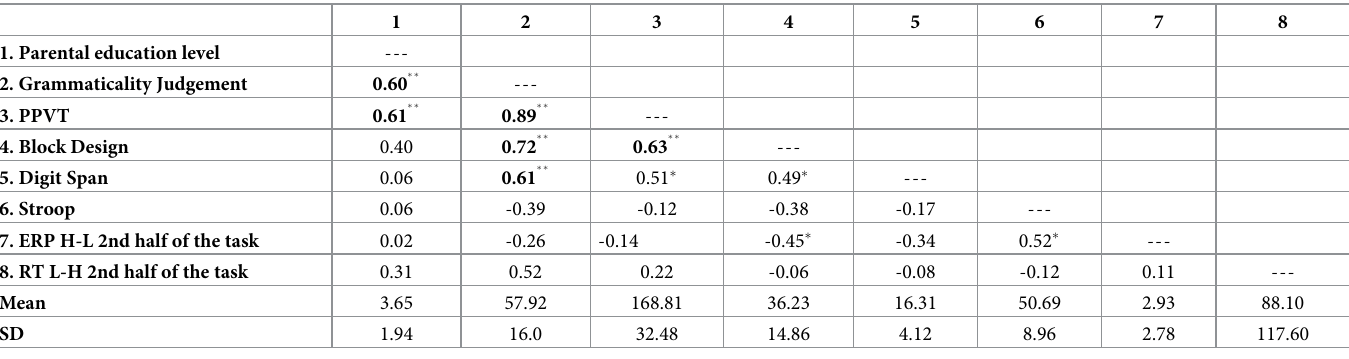
Table 2. Pearson correlations (controlling for age) and descriptive